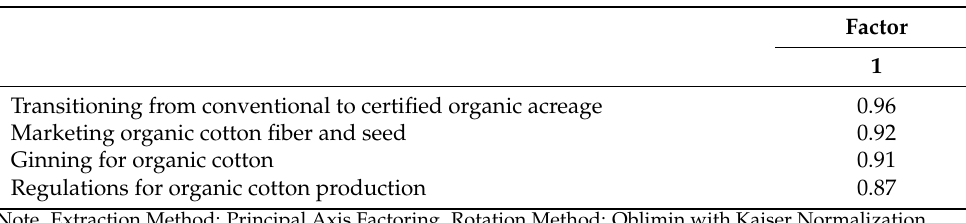
Table 17. Factor loading and proficiencies of organic cotton production competencies.